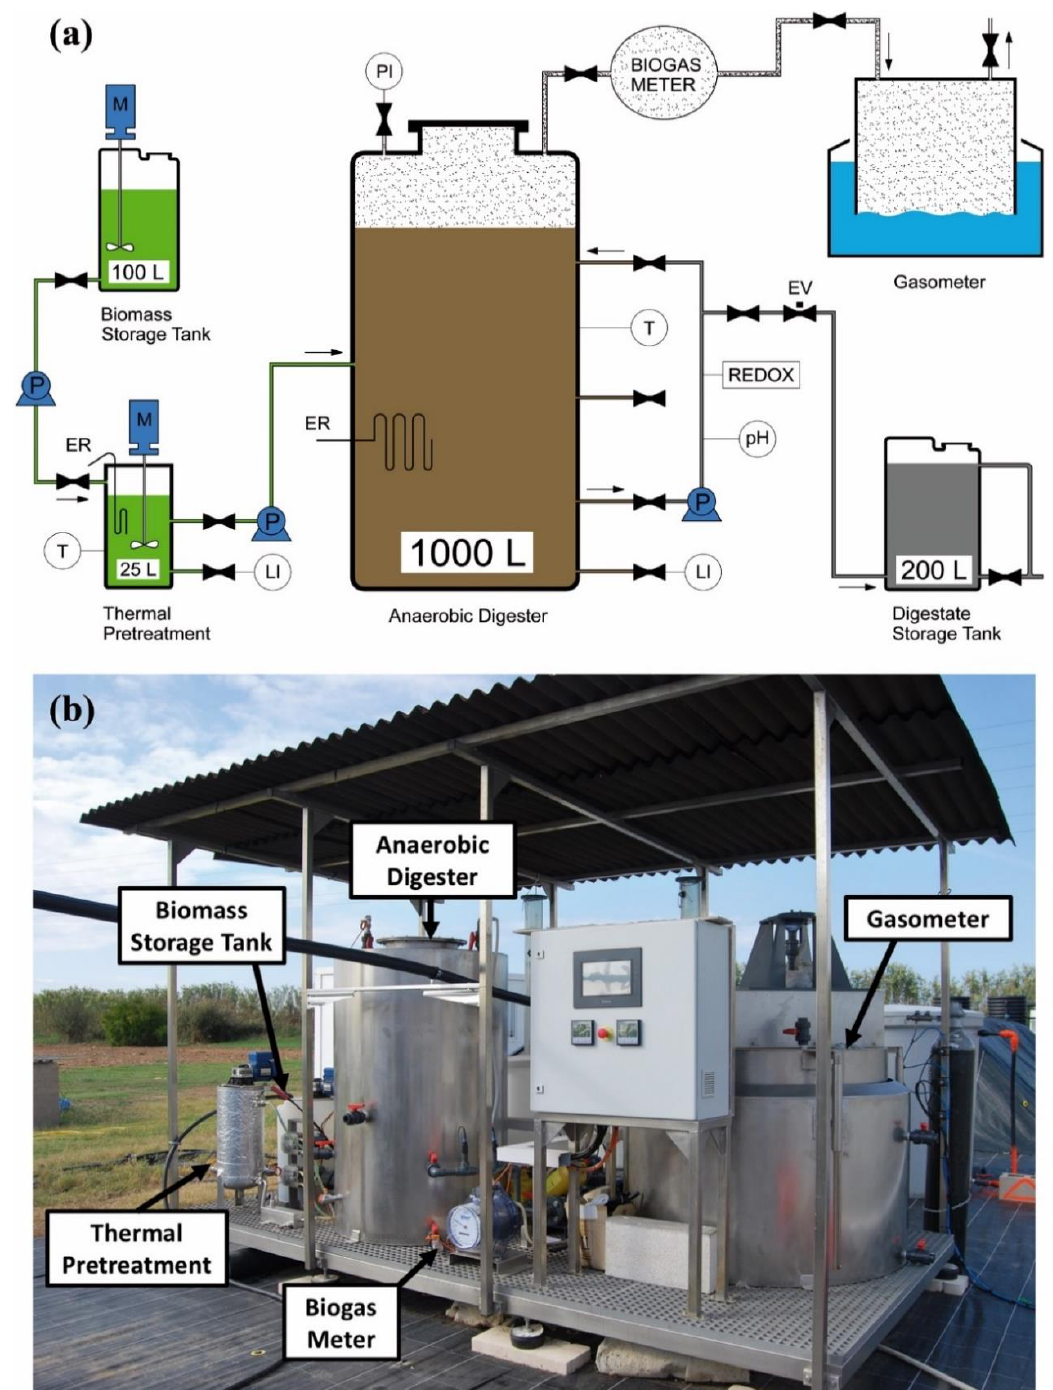
Figure 2. ( a ) Diagram of the anaerobic digestion plant. Mixers (M), pumps (P), electrical resistances (ER) and electrovalves (EV) are indicated in the figure, as well as the temperature (T), liquid level (LI), pressure (PI), redox and pH sensors. ( b ) Image of the anaerobic digestion plant.